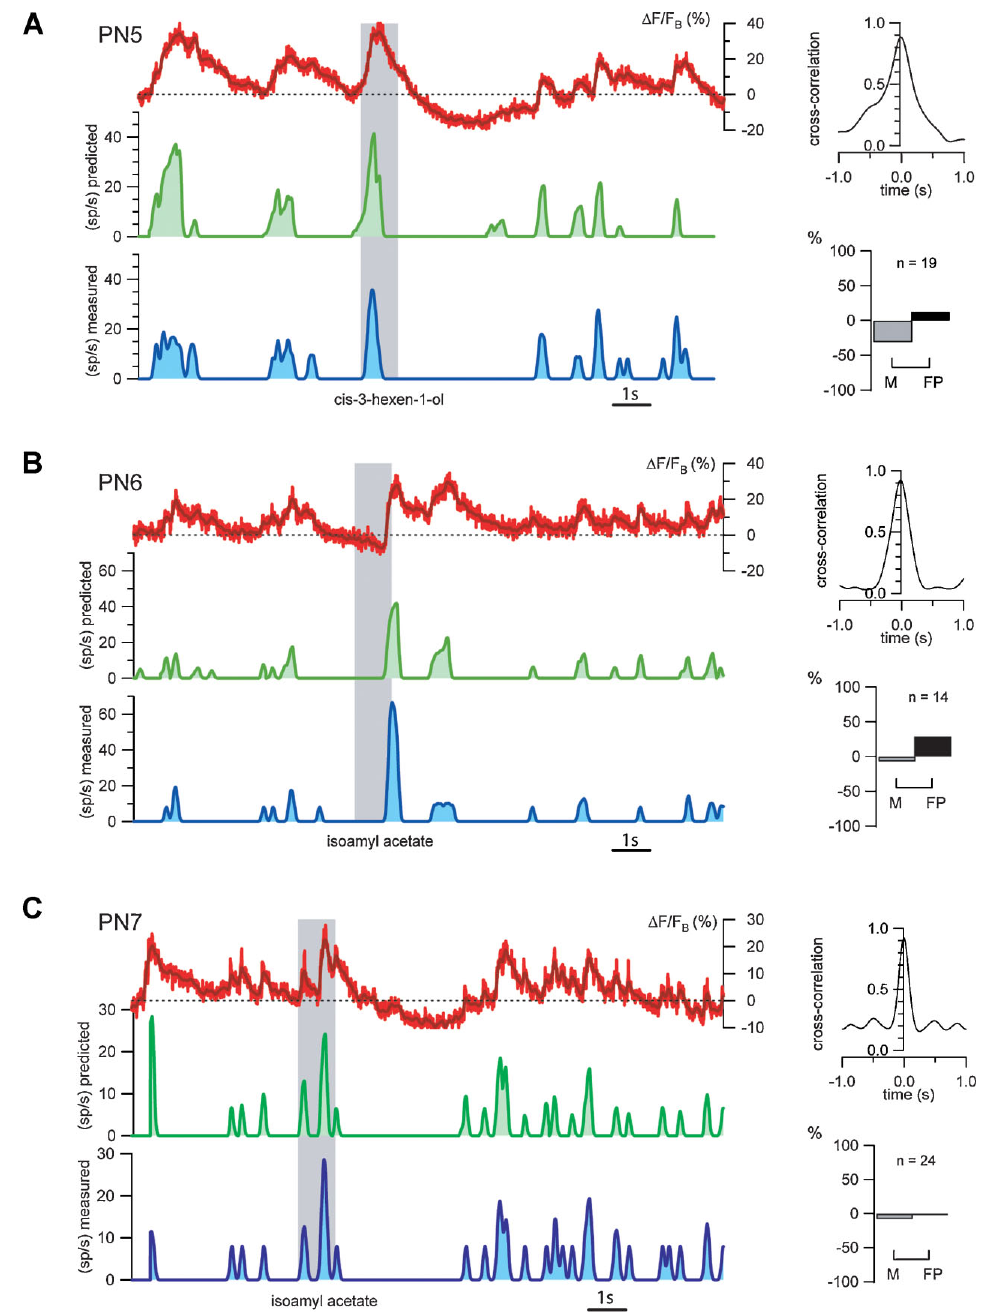
Figure 7. Firing rate prediction from (cid:1) F / F as applied to three different PNs . ( A – C ) Left: raw and smoothed (red and dark red) fluorescence traces ( ∆ F/F B ), predicted (smoothed) firing rate (green), measured (smoothed) firing rate (blue). Right: assessment of match between estimated and measure rates; top: normalized cross-correlation; bottom: proportions of missed and false positive events. In each example, 15seconds of 24-second-long, single trials are shown. Theonlyexperiment-specificparameterisF B (dashedlines),measuredasminimumcalciumsignalbeforetheodorpresentation;F B thusrequiresnomanipulation of membrane potential, and is not the same as F 0 . All other parameters (S, Tc, and the threshold; see text and next figure) are fixed and identical for all. Note high accuracy for predicted firing for PN7 and small false positive percentage for all three